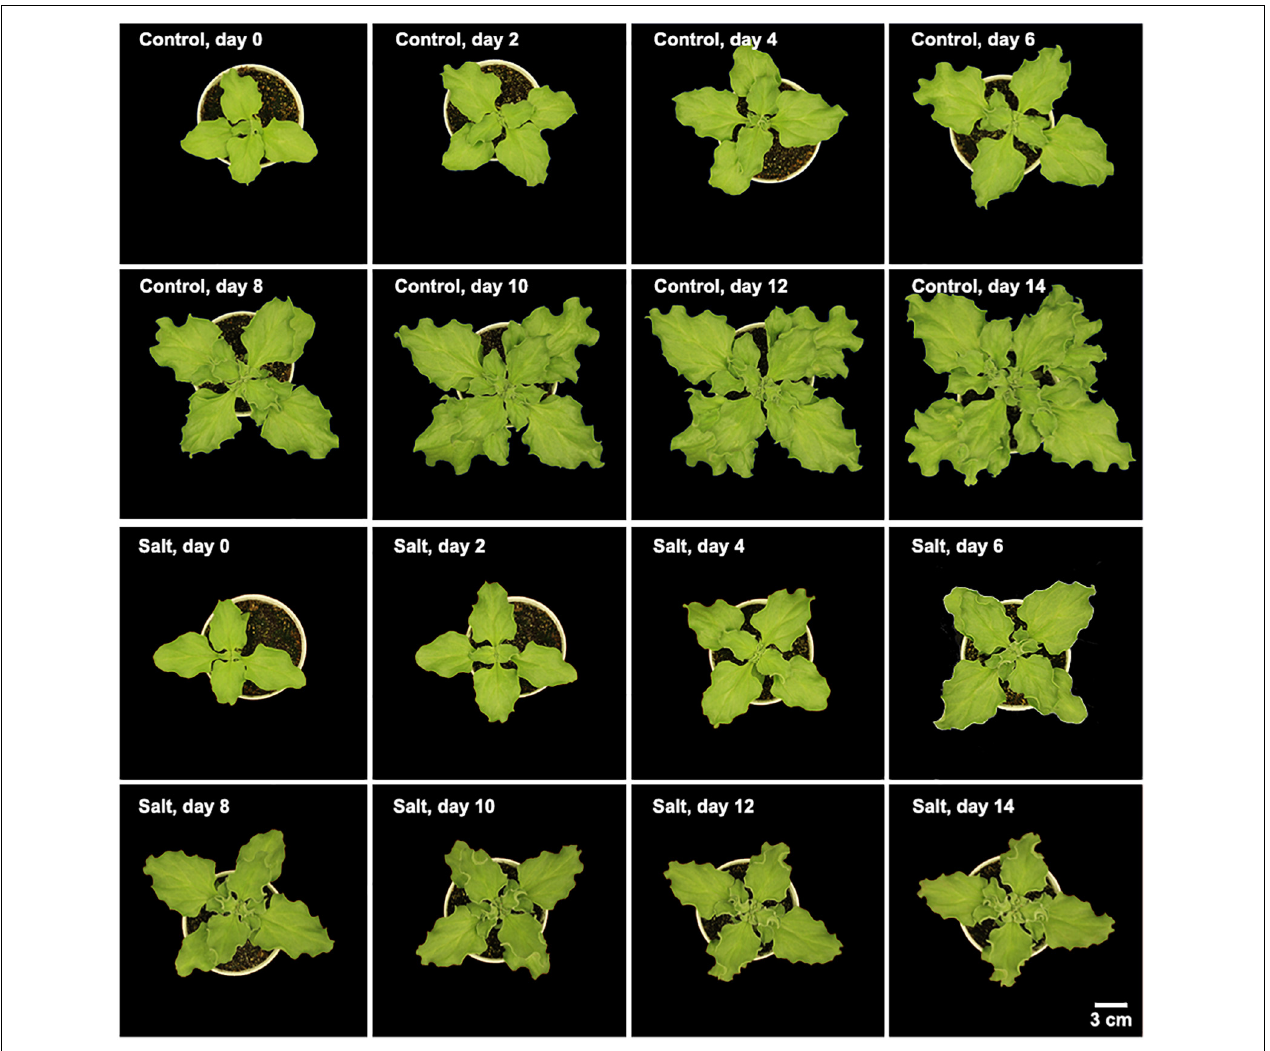
FIGURE 1 | Morphology of M. crystallinum seedlings growing under control and salt treatment for 14 days. Each image is representative of the seedlings at 12 pm in the four biological